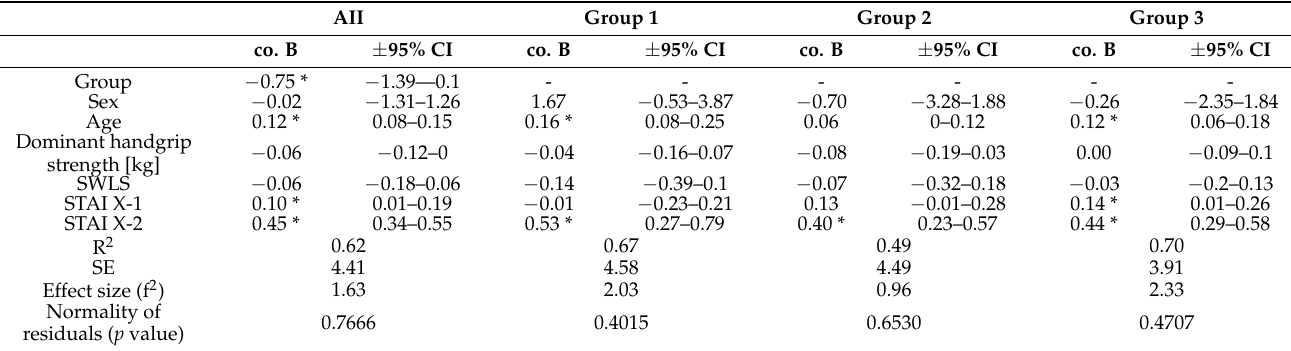
Table 9. A multivariate regression model for all patients combined (All) and for each study group separately, indicating the association of depression with selected